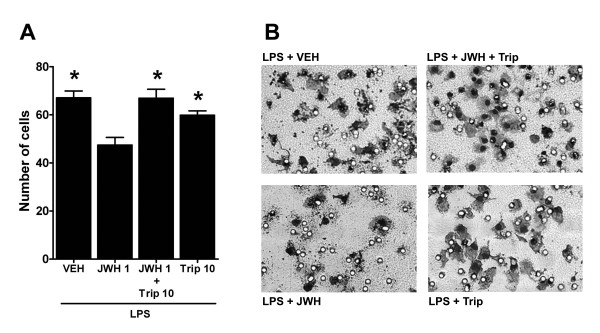
Blockade of the JWH015 effects in microglial migration by MKP-1 and MKP-3 inhibition. (A) JWH015 1 μM (JWH 1) significantly reduced the number of LPS-stimulated microglia that migrated towards ADP and triptolide 10 μM (Trip 10) blocked this effect. Triptolide 10 μM did not modify the number of LPS-stimulated microglia that migrated towards ADP. *p < 0.05 vs. JWH015 group. (B) Representative photomicrographs of the migration chamber membranes with attached microglial cells stained with crystal violet. Cells (black) migrated through the pores (white circles) and towards ADP placed into the lower well.